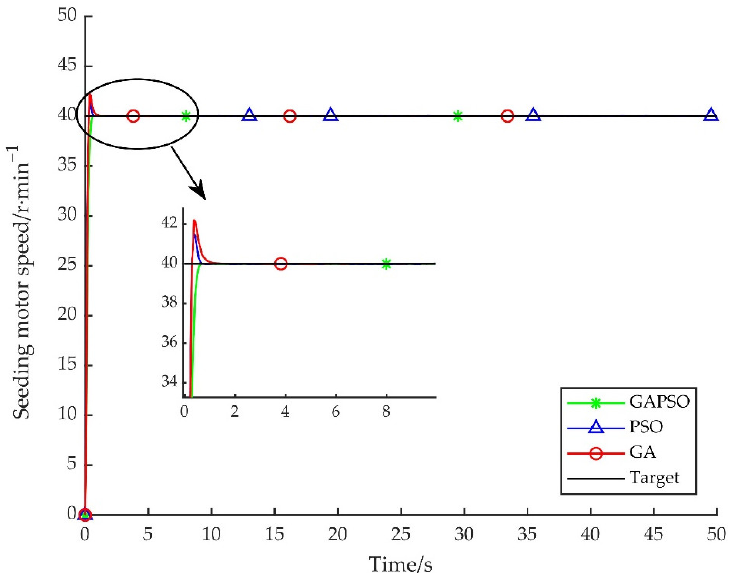
Figure 6. Response curves of three control strategies.